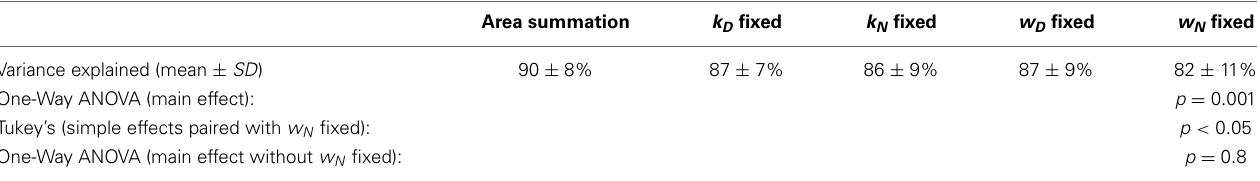
Table 2 | Model comparisons across feedback